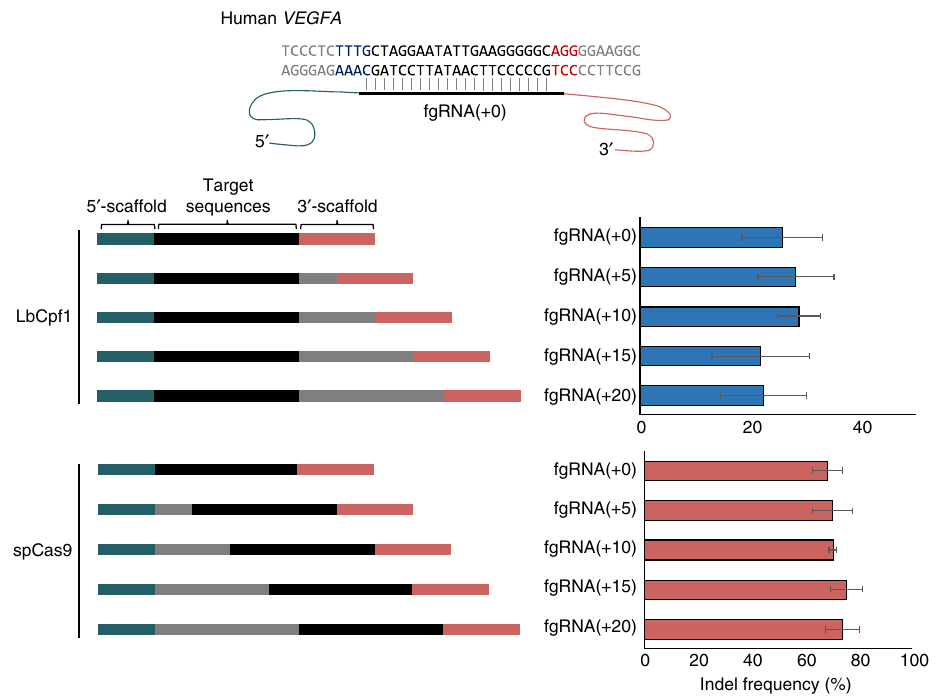
Fig. 3 Endogenous indel frequencies according to the lengths of the target sequences between the 5 ′ - and 3 ′ -scaffolds. Top, human VEGFA target sequences and fgRNAs are shown. PAM sequences of LbCpf1 (TTTG) and spCas9 (AGG) are colored blue and red, respectively. The mimetic construct of fgRNAs is described; blue – green and pink colors represent 5 ′ -scaffolds of LbCpf1 and 3 ′ -scaffolds of spCas9, respectively. Bottom, endogenous indel frequencies are shown based on different lengths of fgRNAs, as measured using targeted deep sequencing. Each target sequence is listed in Supplementary Table 1. Error bars indicate s.e.m. ( n =